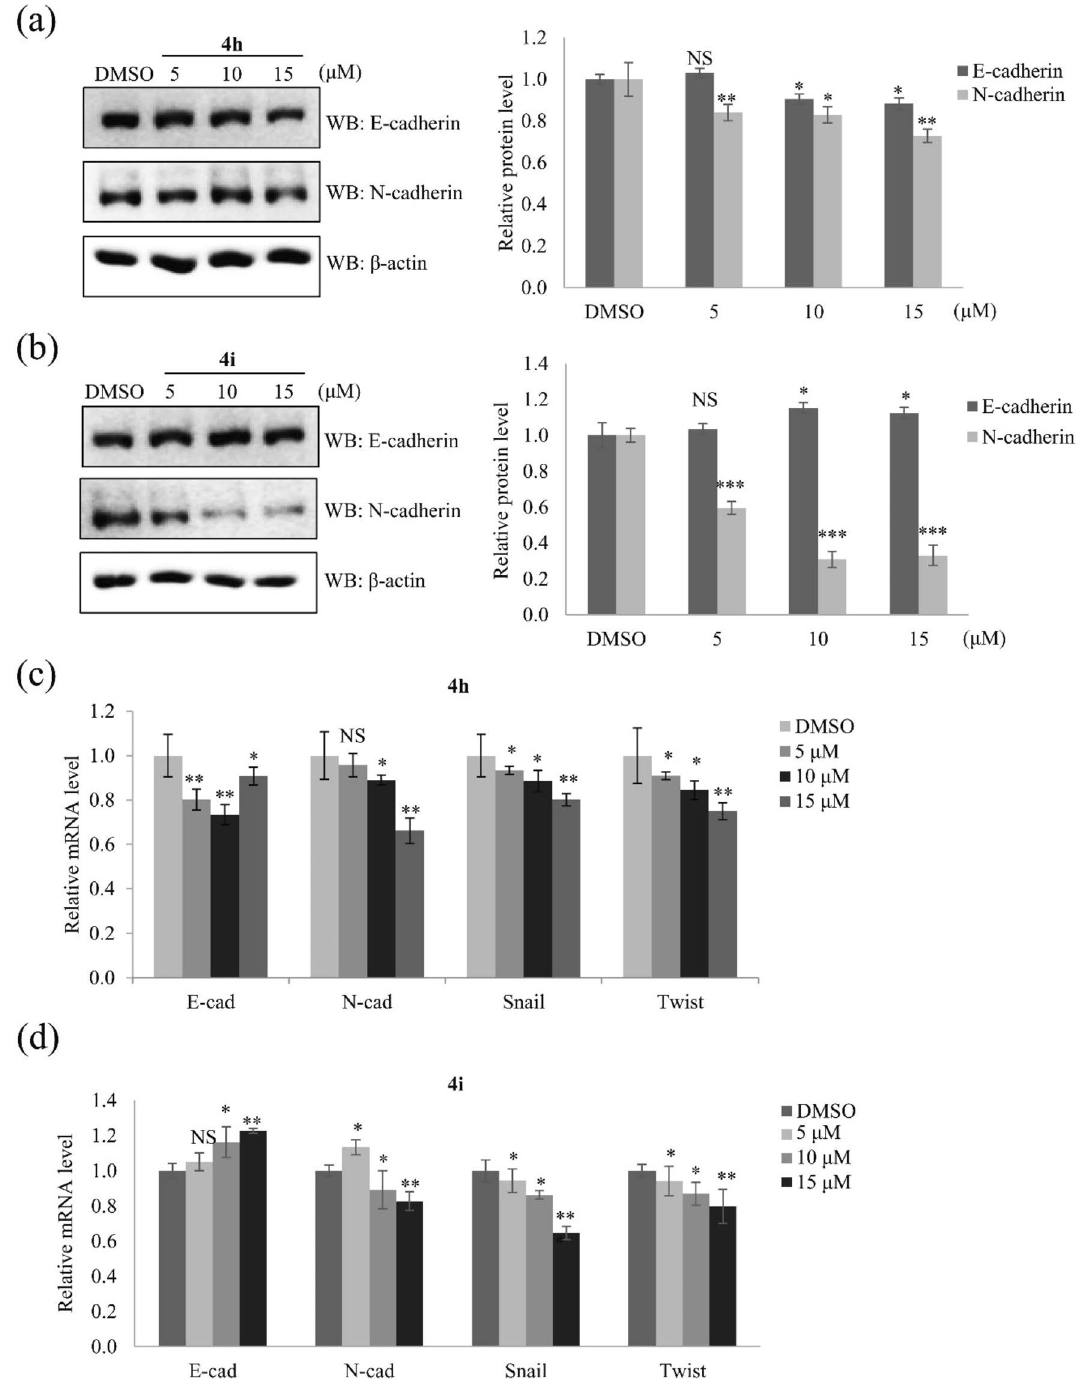
Figure 7. Compounds 4h and 4i suppress A549 cell motility by modulating expression of EMT markers and their regulators. ( a , b ) Western blotting and quantification of the relative protein levels of E-cadherin and N-cadherin in A549 cells treated with nontoxic concentrations (5, 10, and 15 μM) of compounds 4h and 4i . β-Actin served as a loading control. ( c , d ) Relative mRNA levels of EMT effectors (E-cadherin and N-cadherin) and their transcription factors (Snail and Twist) in A549 cells treated with nontoxic concentrations (5, 10, and 15 μM) of compounds 4h and 4i . The mRNA levels were normalized against that of the housekeeping gene GAPDH. Quantitative data were obtained from at least three independent experiments. Data represent the mean ± SD. Statistical analysis was performed by a one-way analysis of variance. * p < 0.05; ** p < 0.01; *** p < 0.001; NS, no significant difference compared with DMSO-treated A549